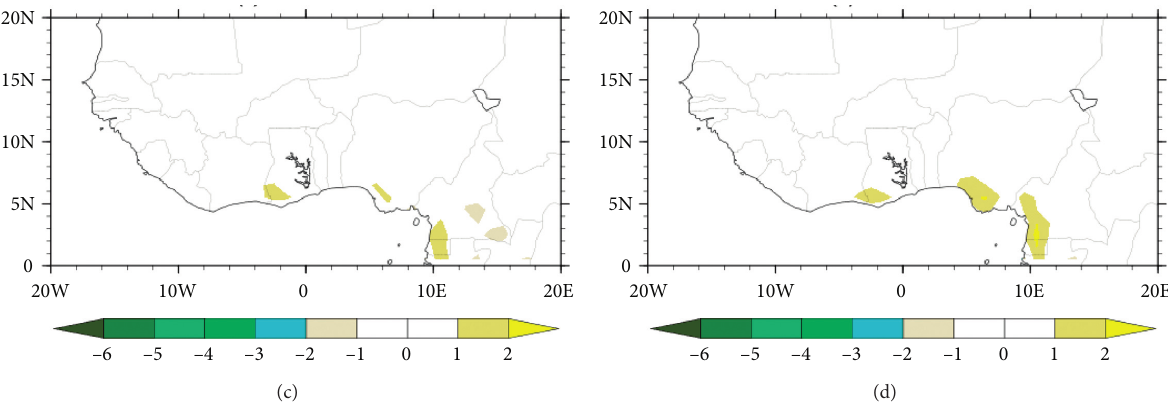
Figure 10: Spatial bias of precipitation for Dec. 16 th , 2011–Feb. 28 th , 2012. (a) Noah-MP groundwater option-TRMM. (b) Noah-MP- TRMM. (c) Noah-TRMM. (d)